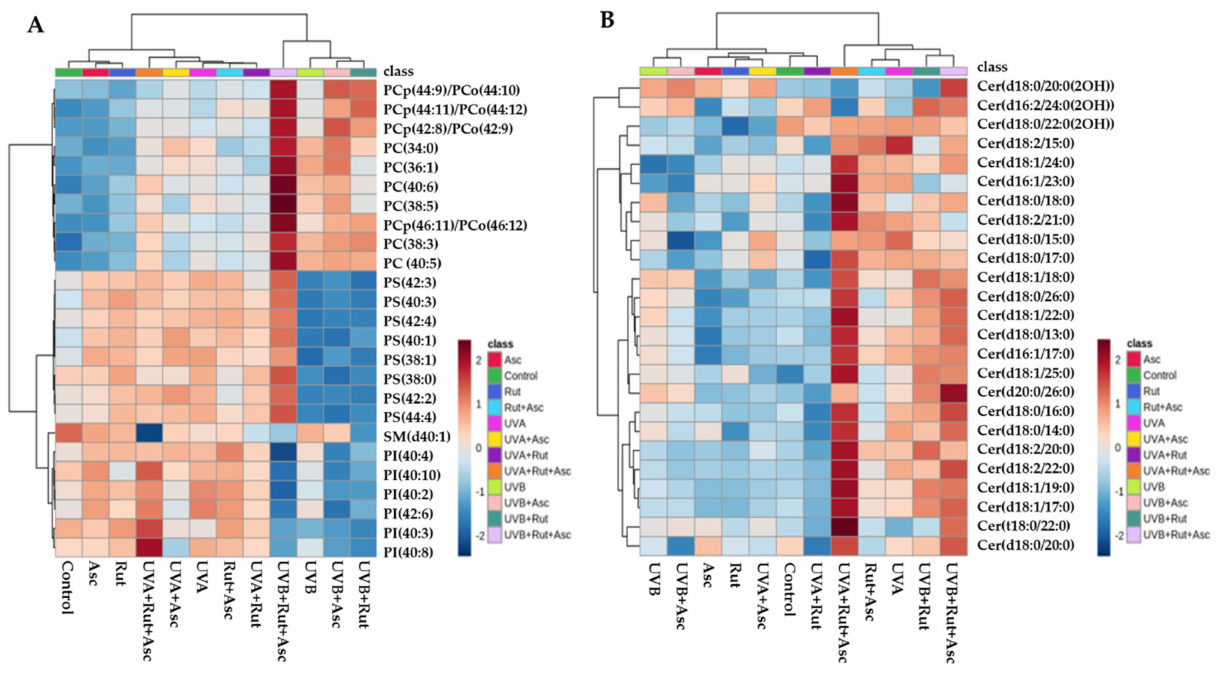
Figure 4. Two-dimensional hierarchical clustering heat map of the 25 most discriminating phospholipid ( A ) and ceramide ( B ) molecular species (according to one-way ANOVA and Tukey’s post-hoc tests) of the 12 studied 3D cultured fibroblasts groups. Levels of relative abundance are indicated on the color scale, with numbers indicating the fold difference from the grand mean. The clustering of the sample groups is represented by the dendrogram on the top. The clustering of individual phospholipid species with respect to their similarity in change of relative abundance is represented by the dendrogram to the left. Abbreviations: Asc, ascorbic acid; Rut,